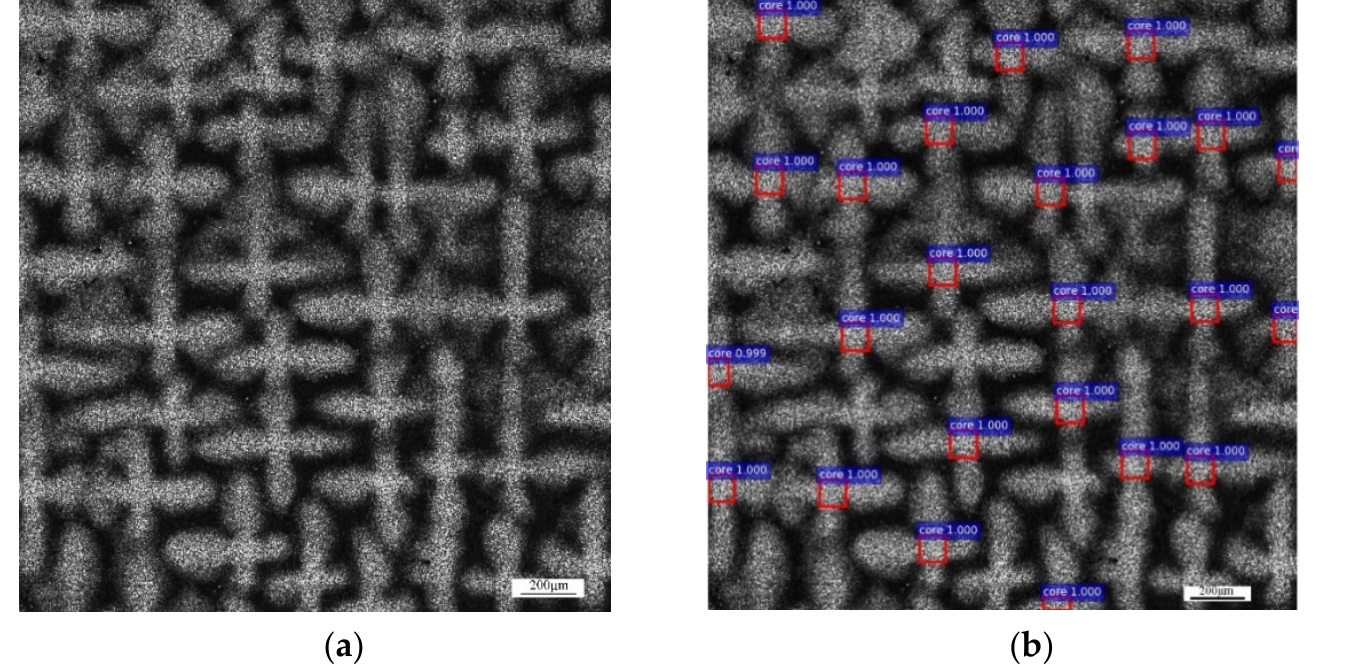
Figure 6. The extraction results. ( a ) Original image. ( b ) Detected result by Faster R-CNN.